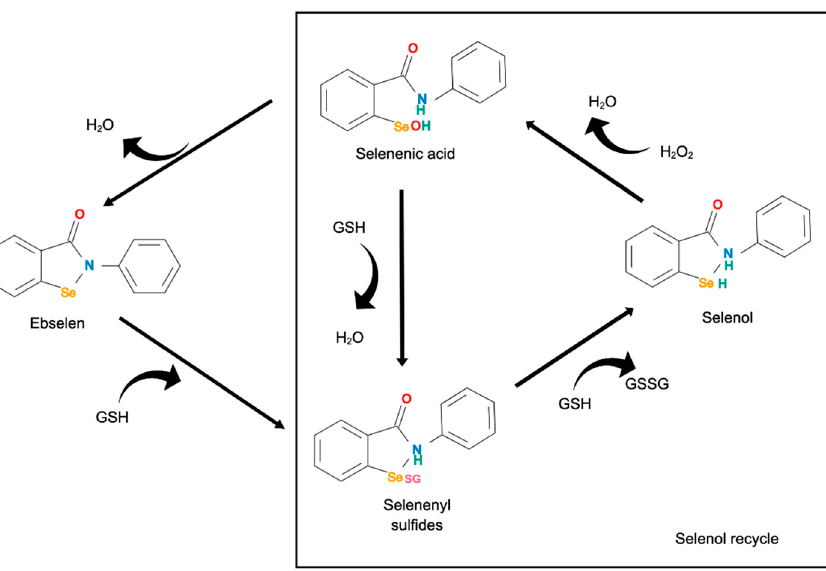
Figure 4. The GPx-like cycle effect of ebselen on hydrogen peroxides. Ebselen reacts with thiol- containing molecules, such as GSH, to form an intermediate of selenenyl sulfides before reacting with another GSH to form selenol and oxidized GSH (GSSG). Selenol reacts with peroxides, such as hydrogen peroxide (H 2 O 2 ), to form water and selenenic acid, which can be recycled to selenol in a two-step reaction using GSH in each step. The figure was adapted from Kade , et al. [72] and Nogueira and Rocha [73]. The box indicates the recycling process of selenol. H: hydrogen; O: oxygen; N: nitrogen; Se: